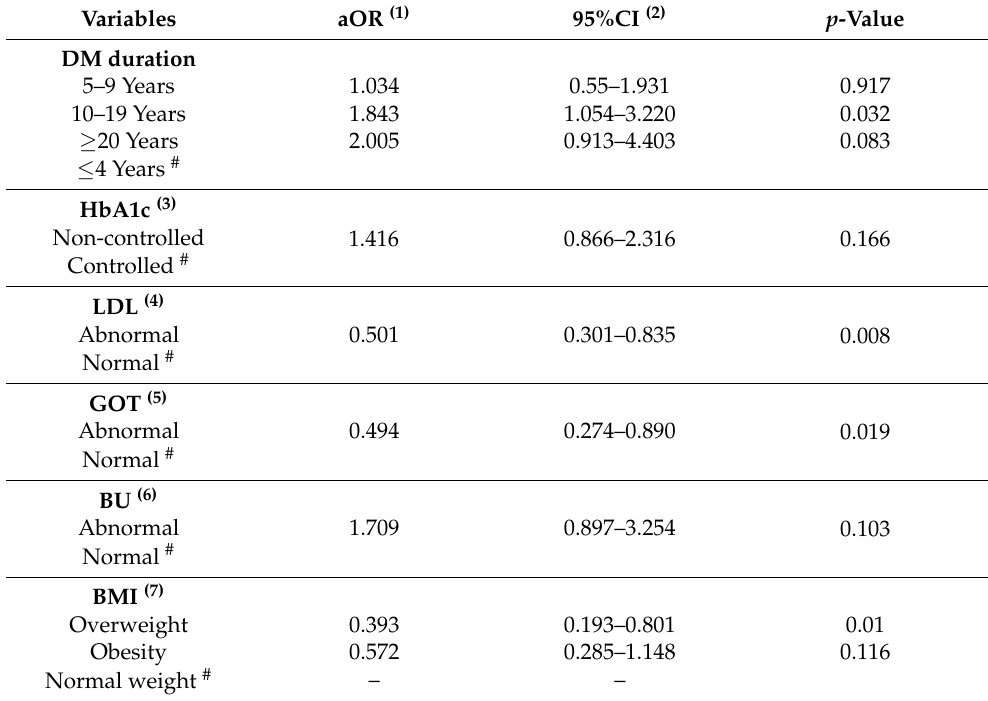
Table 4. Multivariate logistic regression for factors associated with diabetic retinopathy.